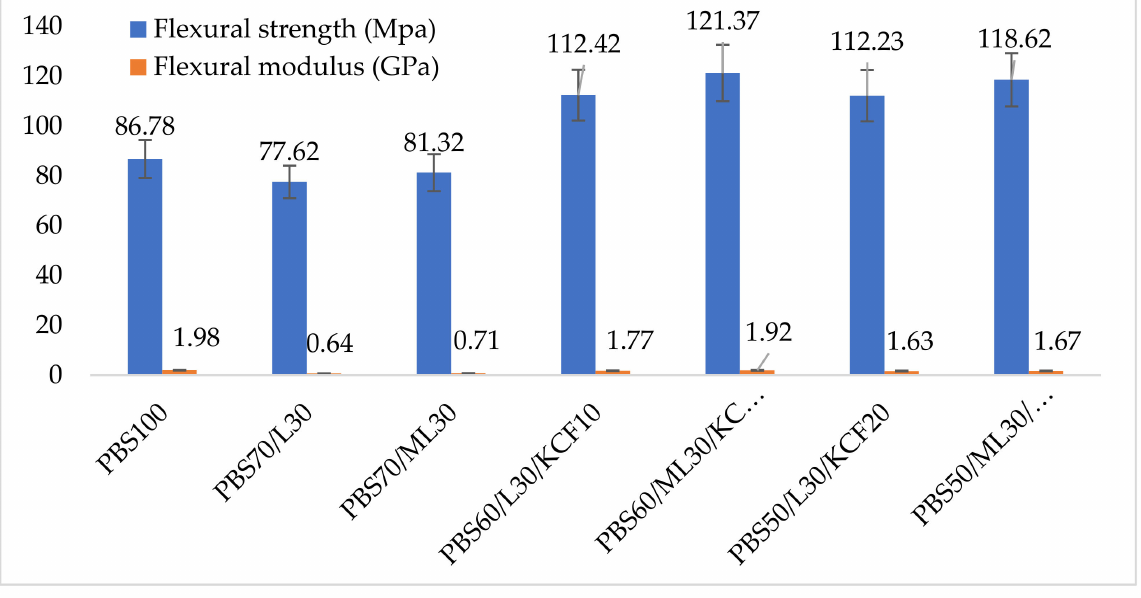
Figure 8. Flexural properties of PBS and its composites. Note: Poly (butylene succinate) (PBS), Lignin (L), Modified Lignin (ML), Kenaf Core Fiber